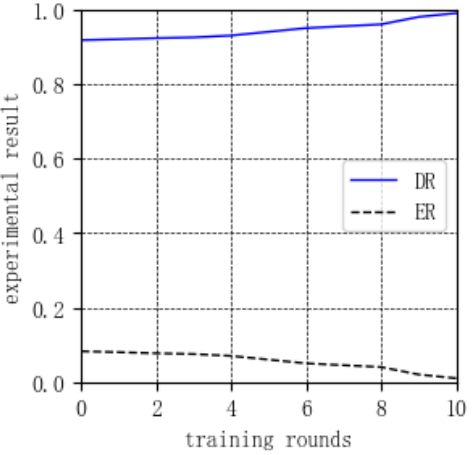
Figure 7. Optimizing experiment